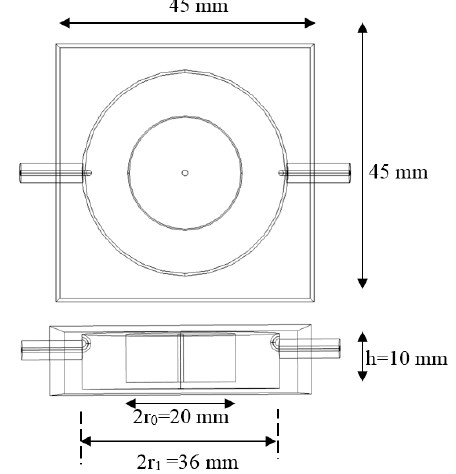
Figure 4. Re-entrant cavity dimensions.